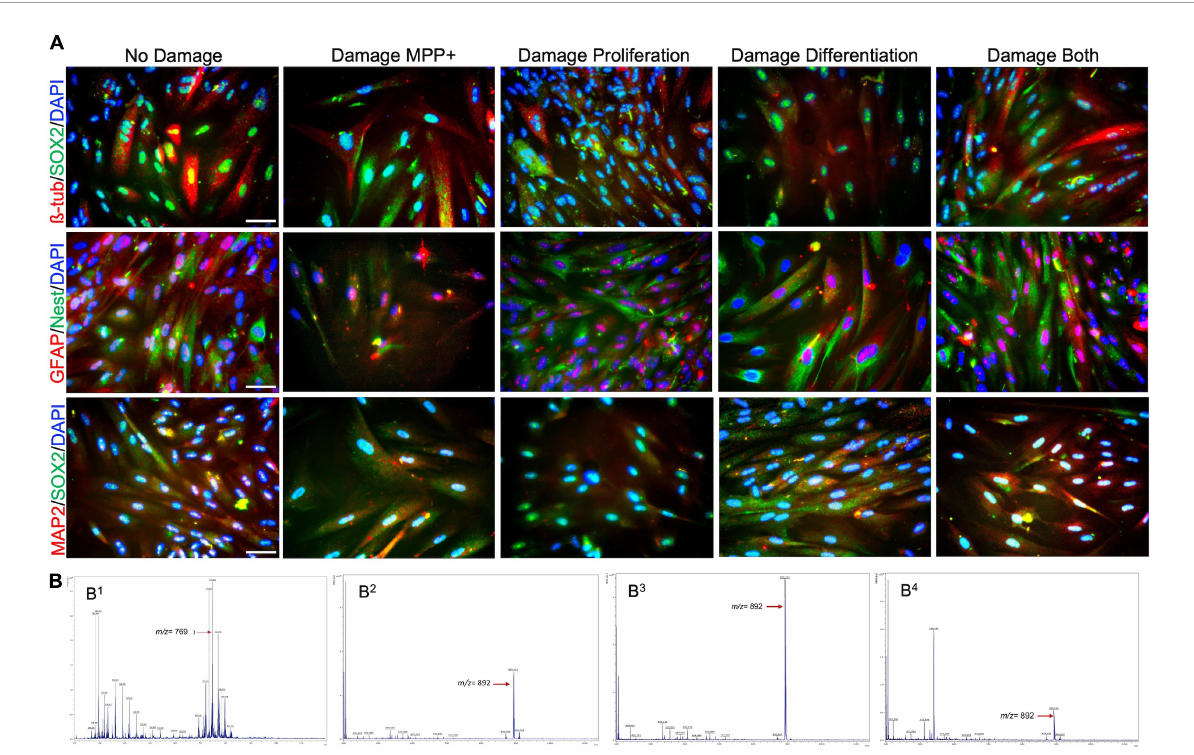
FIGURE5 Expression of cell surface antigen markers of neuronal stem cells (NSCs) and MALDI-TOF spectra during cell differentiation. (A) Colocalization of antigens β -tubulin/SOX2 (red/green), GFAP/Nestin(red/green), and MAP2/SOX2 (red/green), and nuclear counterstaining marker DAPI (blue), in different conditions posterior to differentiation protocol from hMSCs to NSCs. (B) MALDI-TOF spectra of NSCs from human mesenchymal stem cells. (B 1 ) hMSCs using DHB30, (B 2 ) hMSCs differentiated using DHB30, (B 3 ) hMSCs damage induced by MPP without antioxidants, and (B 4 ) hMSCs damage induced by MPP with antioxidants during differentiation. Scale bar: 25 µ